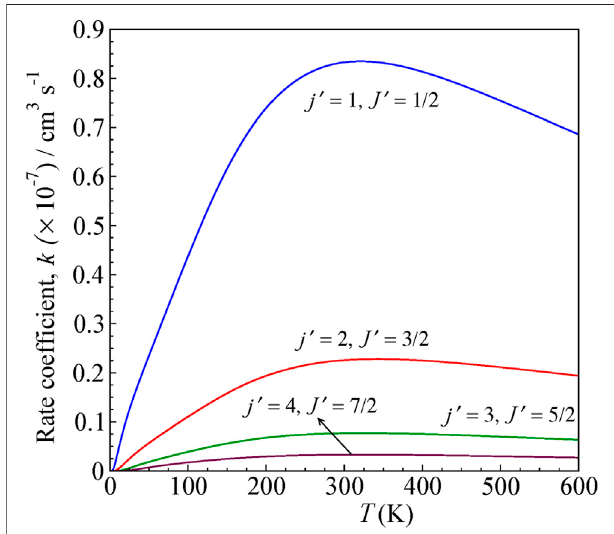
FIGURE 7 | State-to-state rate as a function of temperature for 0 – 600 K computedfor Δ J ≠ Δ j transitionsfromtheinitiallevel j (cid:1) 0and J (cid:1) ½forH + + CN ( j (cid:1) 0 , J (cid:1) ½) → H + + CN ( j ’ ,J ′ )